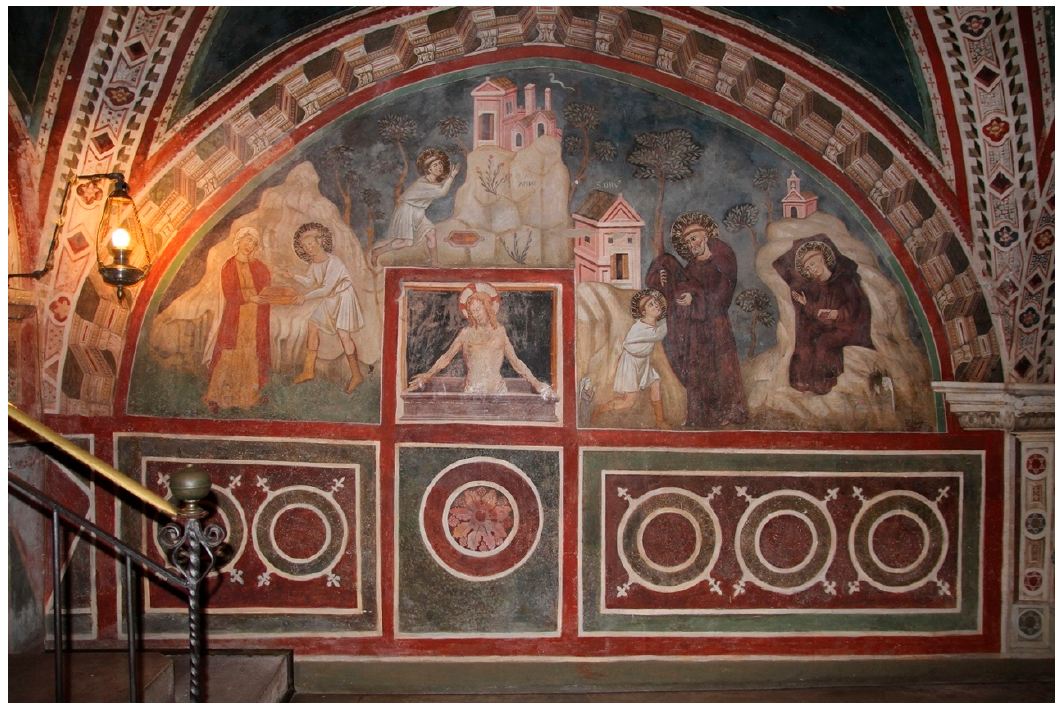
Figure 8. Sacro Speco, Subiaco (Italy), Lower Church. First episodes of the Life of St. Benedict. Photo: Roberta Cerone.